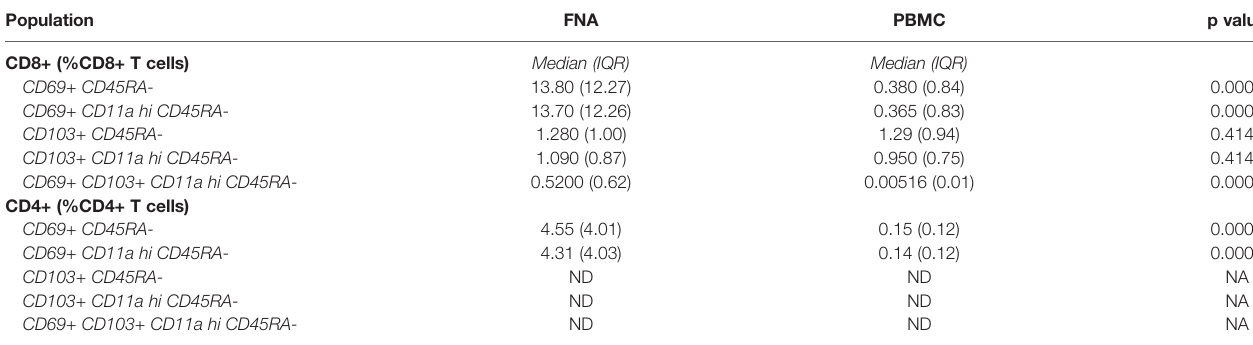
PopulationsofCD8+andCD4+TcellsexpressingTRMcellmarkers.Representative fl owcytometryplotsfromFNAandPBMCofthesamedonorsisshownin SupplementaryFigure2 . The gating strategy for each of these populations is shown in Supplementary Figure 3 . Wilcoxon matched pairs signed rank tests were used to check for signi fi cance of differences betweenFNAandPBMCsamples.Anexactpvalueisreported.Valuesreportedaremedianswithinterquartileranges.Effectivepairing,checkedbySpearmancorrelationcoef fi cient,was presentforallsamples(p<0.05).FNA, fi neneedleaspirate.IQR,interquartilerange.NA,notapplicable.ND,notdetected.PBMC,peripheralbloodmononuclearcells.TRM,tissue-resident memory T